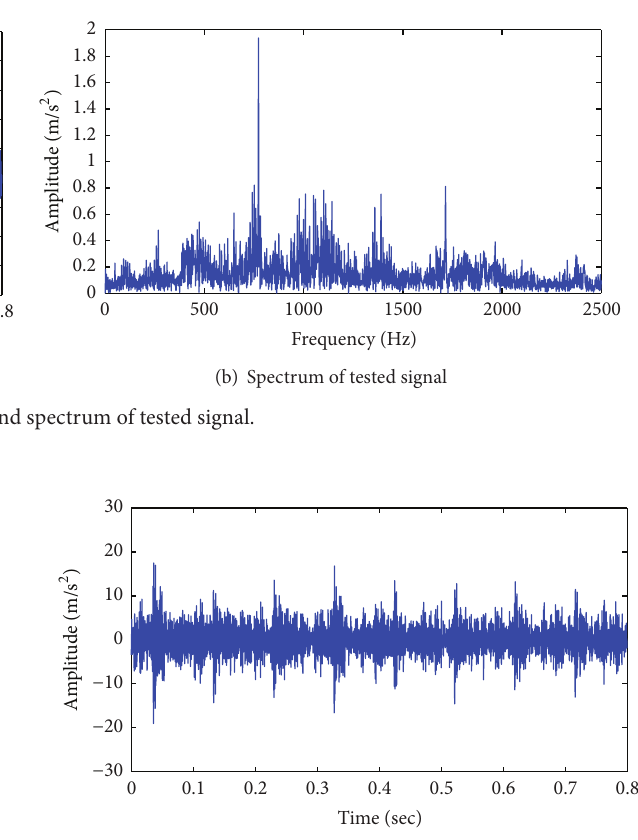
Figure 6: The waveform of the signal after noise